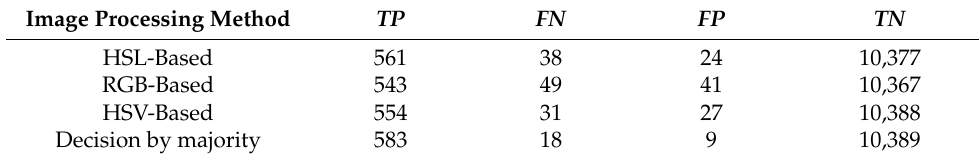
Table 5. Statistical